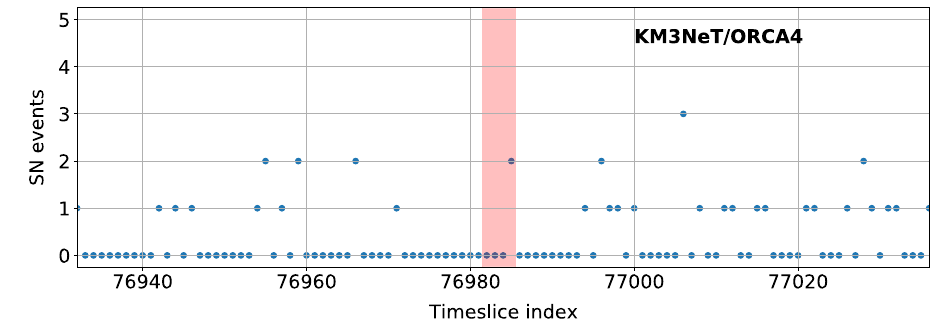
Fig. 8 Number of SN events per timeslice as a function of time (blue markers) for the 10 s around the event time (T0) of the LIGO-Virgo gravitational wave alert S200114f. The timeslices corresponding to the search time window are highlighted in red. The first timeslice in the search time window starts 39 ms before